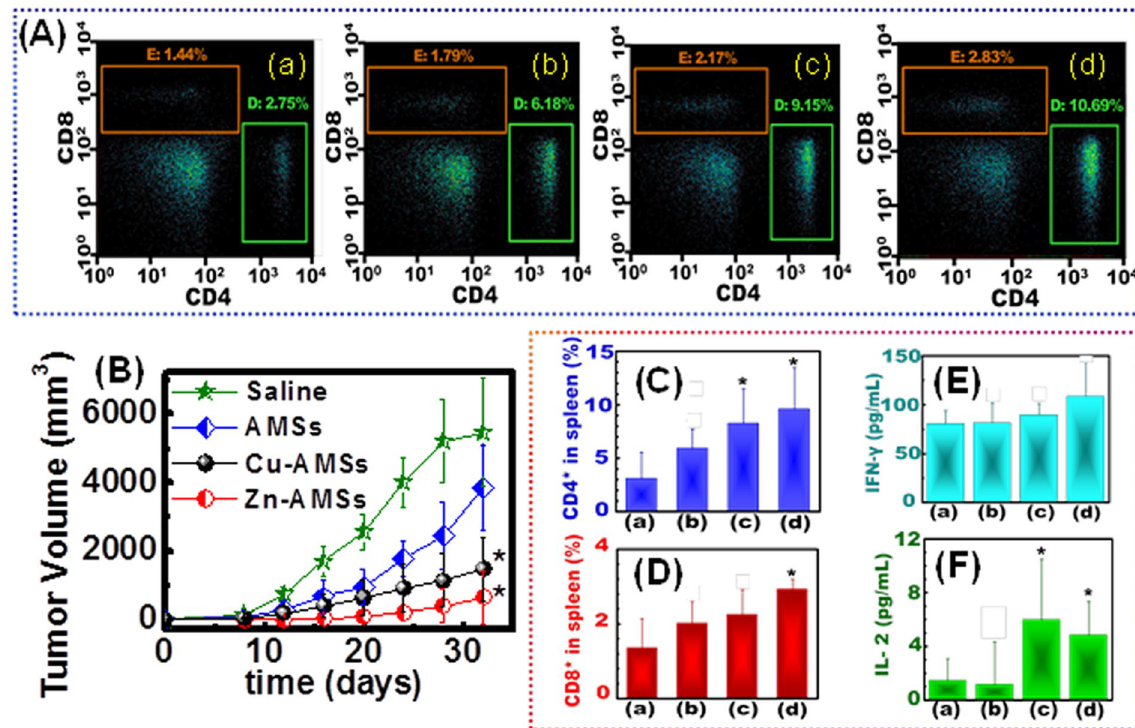
Figure 5. Hierarchical Cu-AMSs and Zn-AMSs induce anti-tumor immunity in an EG7-OVA lymphoma model. ( A ) The CD4 and CD8 cells populations in spleen of mice at the endpoint for control (a), OVA-AMSs (b), OVA-Cu-AMSs (c), OVA-Zn-AMSs (d). ( B ) tumor volume of mouse immunized with OVA-saline, OVA- AMSs, OVA-Cu-AMSs and OVA-Zn-AMSs 32 days after EG-7. OVA cancer cells injection. ( C , D ) Statistic analysis of CD4 ( C ) and CD8 ( D ) cell population in splenocytes. ( E , F ) Cytokines content in spleen of mice at the endpoint for control (a), OVA-AMSs (b), OVA-Cu-AMSs (c), OVA-Zn-AMSs